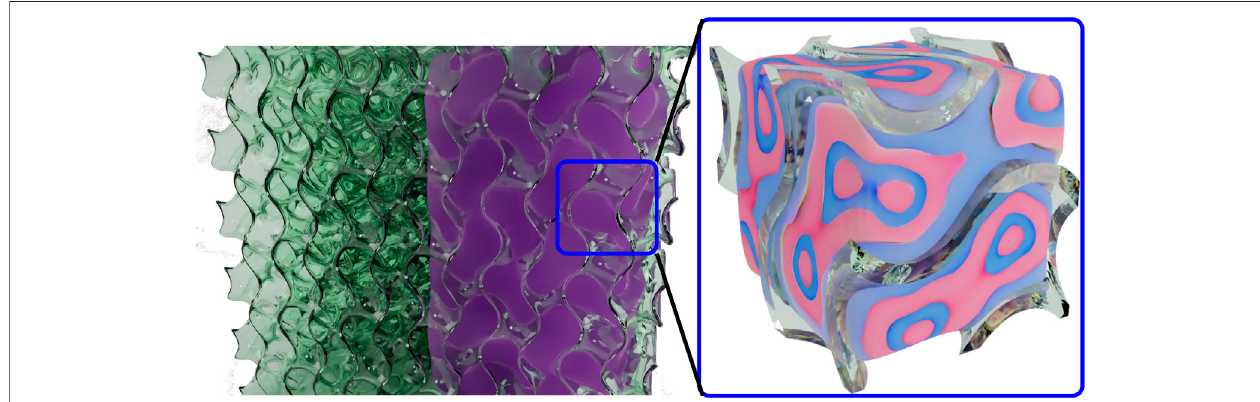
FIGURE 1 | Sketch of the system under investigation. The porous glass (left) is fi lled with IL (right part of the porous glass), which tends to be structured inside the pores in a lamellar fashion (zoom into the fi lled porous glass).